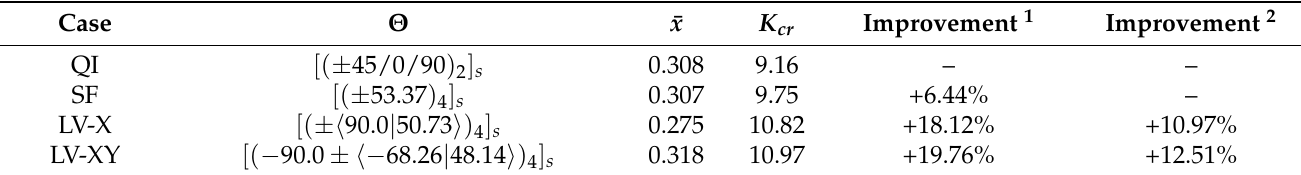
Table 6. Optimal designs and results of the stiffened plate with a central cutout subjected to in-plane shear displacements (w/o AFP manufacturing constraints).